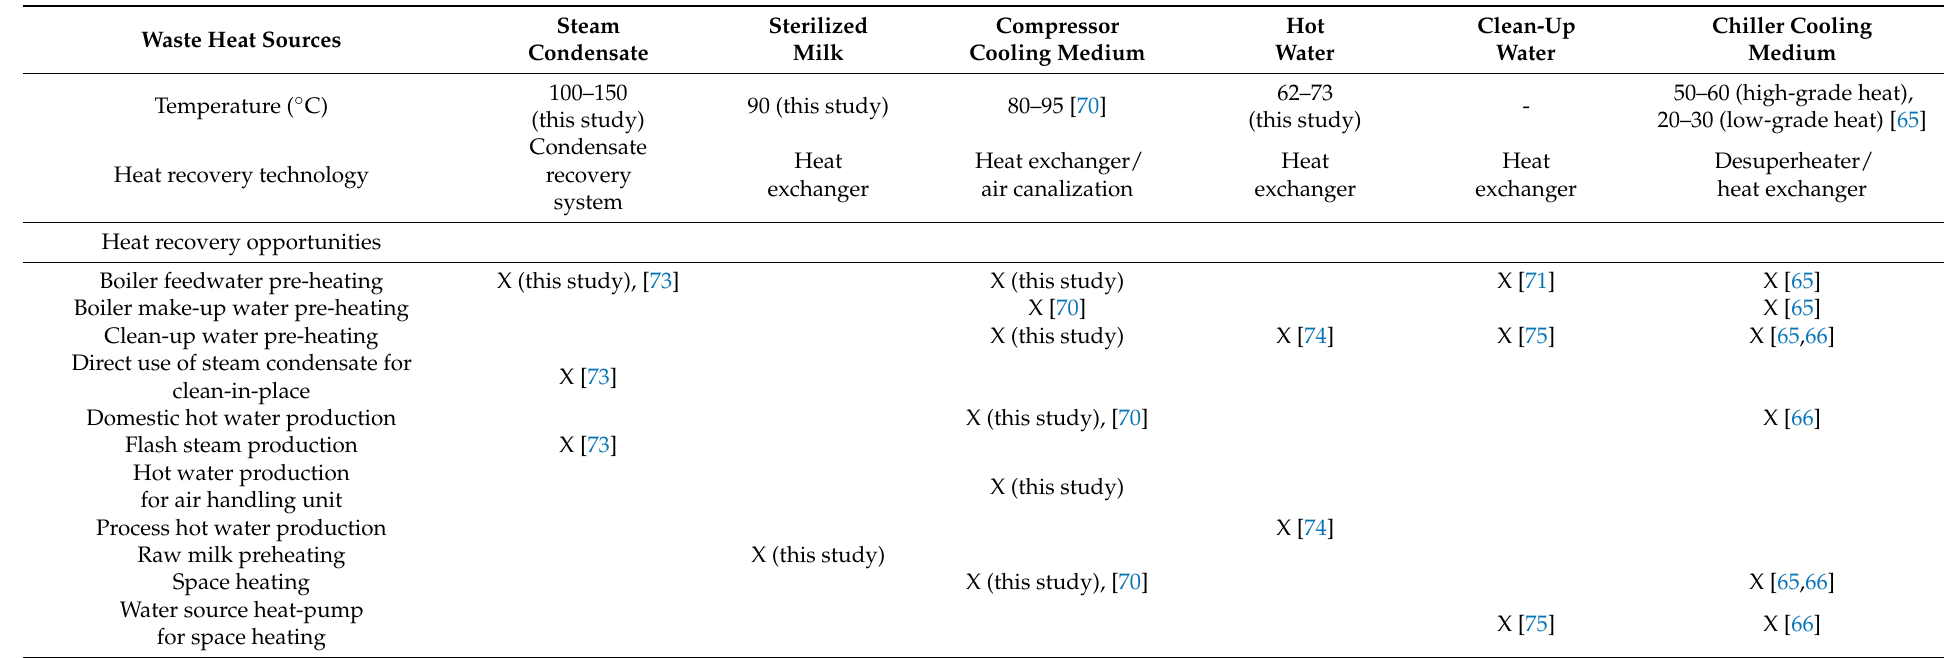
Table A2. Scheme providing the characterization of waste heat sources from UHT milk production and the identification of possible heat